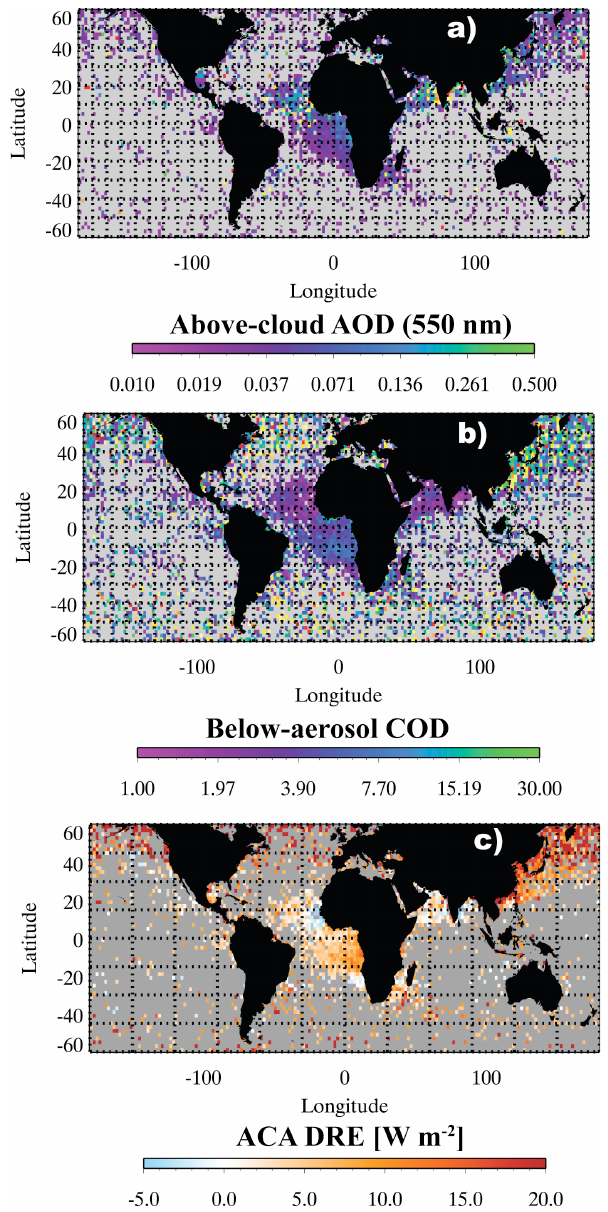
Figure 5. (a) Annual mean AOD (at 550nm) of above-cloud light- absorbing aerosols (i.e., smoke and polluted dust) derived from 4 years (2007–2010) of the CALIOP 5km aerosol and cloud layer products. (b) Annual mean below-aerosol COD derived from the MODIS daily level-3 COD–CTP joint histogram. (c) Annual mean instantaneous TOA DRE of above-cloud light-absorbing aerosols derived using the new